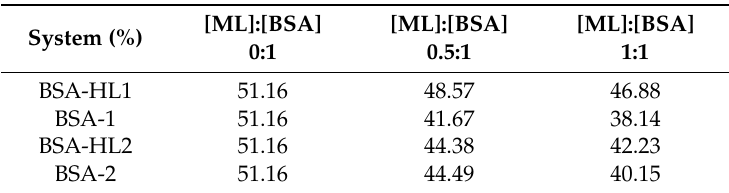
Table 4. The content of α -helix of bovine serum albumin (BSA) in the absence of and presence of HL1, HL2, 1 , and 2 .